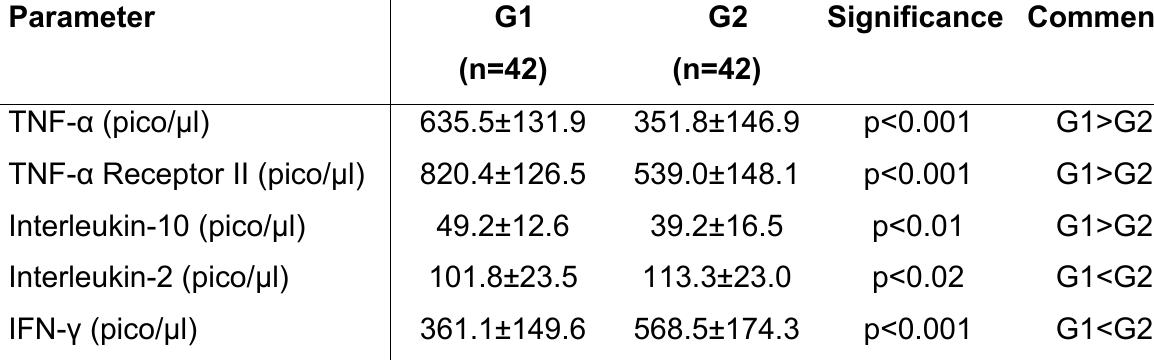
Table 4. Mean ( x ) and standard deviation (SD) of serum cytokines in 84 HIV-1 infected individuals, according to